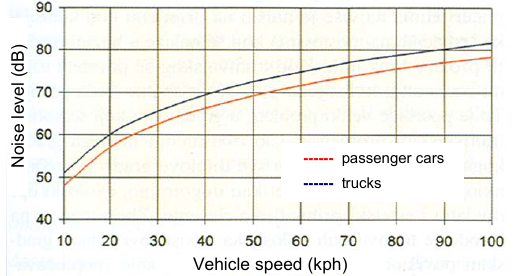
Figure 3 – Influence of vehicle speed on noise levels Рис . 3 – Влияние скорости автомобиля на уровень шума Slika 3 – Uticaj brzine vozila na nivo